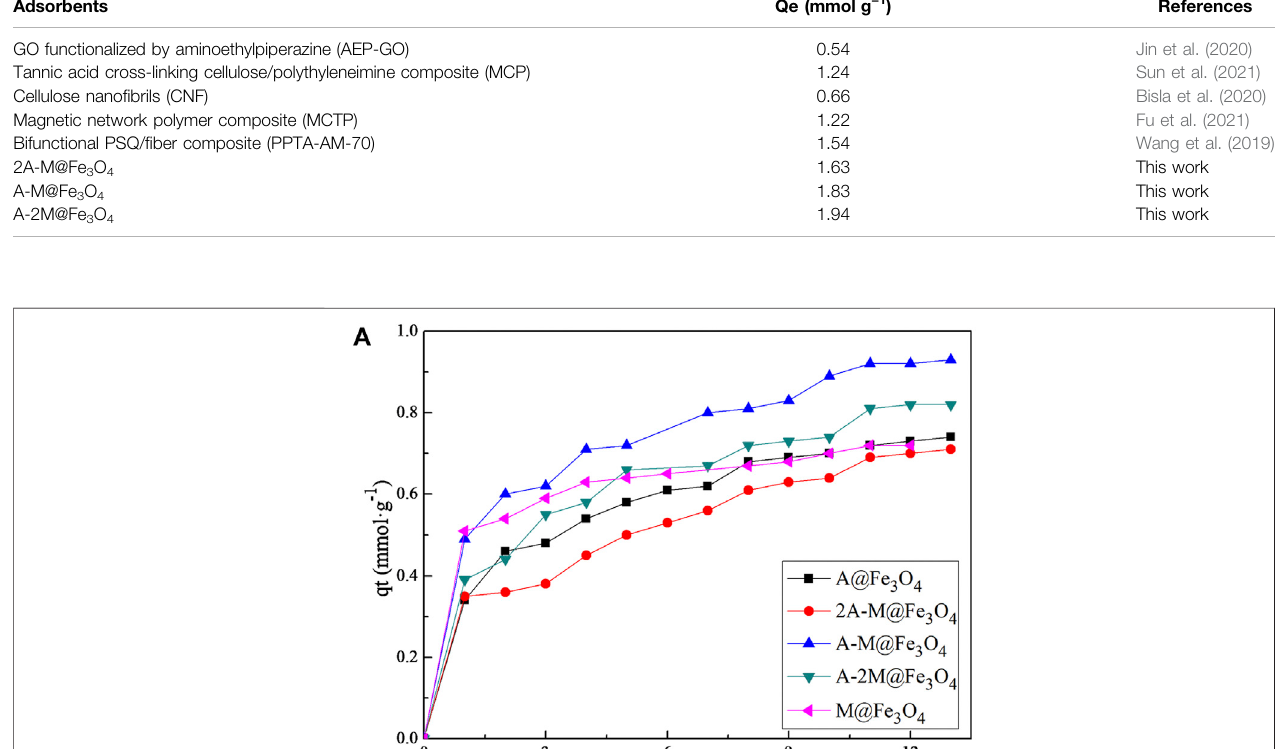
Frontiers in Environmental Chemistry |